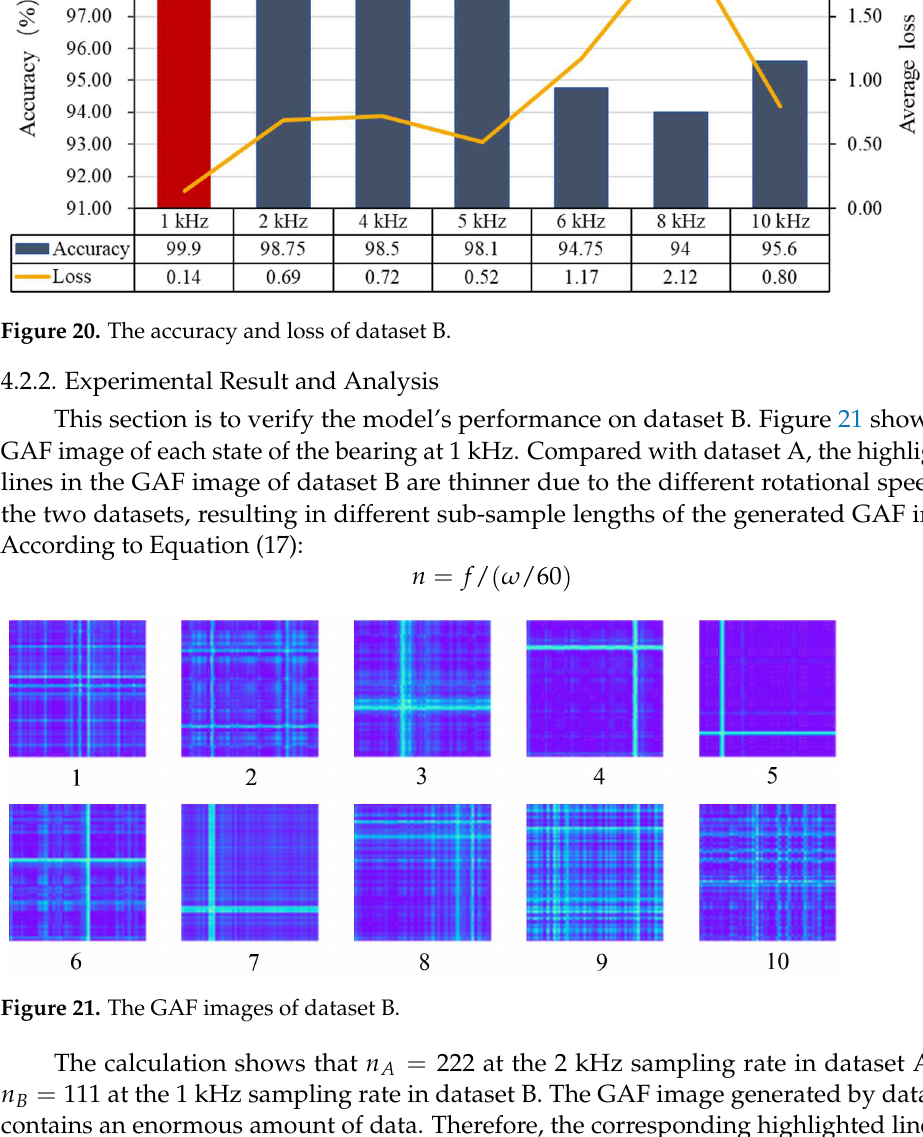
Table 8. Diagnostics result of different methods on Dataset B .